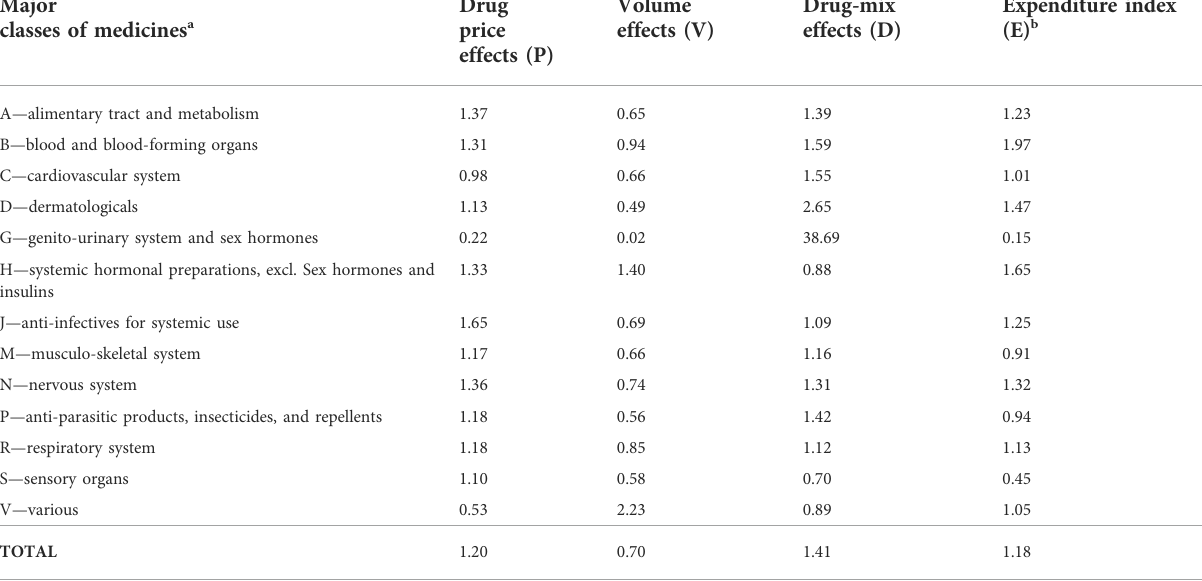
TABLE 2 Results of the decomposition analysis by the major classes of medicines. Minas Gerais, Brazil, 2012-2018. Major classes of medicines